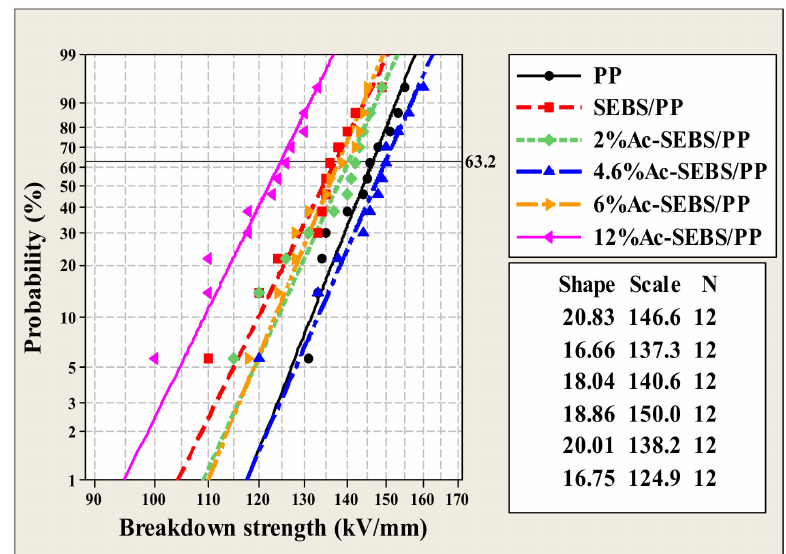
Figure 6. AC breakdown field strength of PP and its